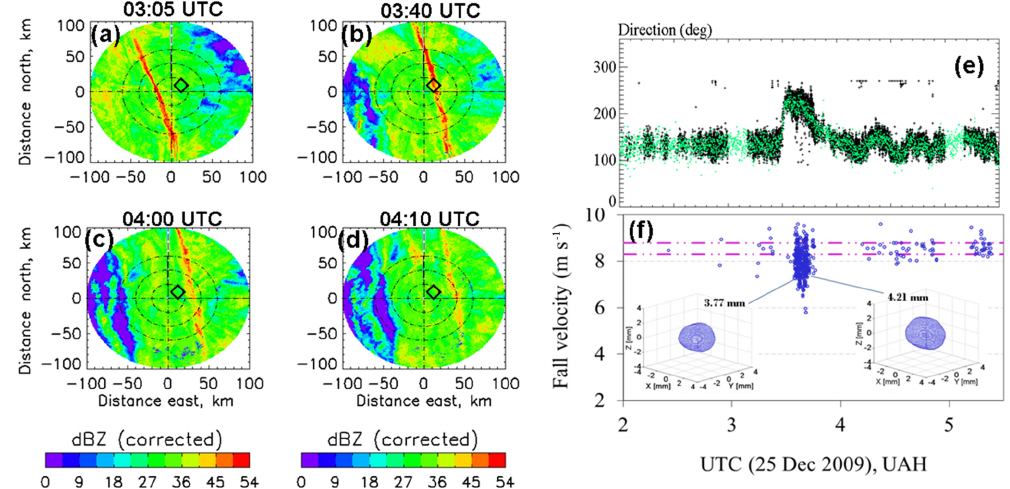
Figure 1. (a–d) show the attenuation corrected radar reflectivity from the C-band ARMOR radar at four time periods during the 25 Decem- ber 2009 event; (e) Wind direction with UTC from the 10m height wind sensor measurements (grey) and the 2DVD-based estimates of drop horizontal velocity direction of all moderate-to-large drops with rotational symmetry axis (black points); (f) fall velocities of 4 ± 0 . 25mm drops with UTC (blue points) and the expected (i.e., fit to Gunn-Kinzer laboratory data) fall velocity range as dashed purple lines, and two examples of reconstructed asymmetric drops are shown as